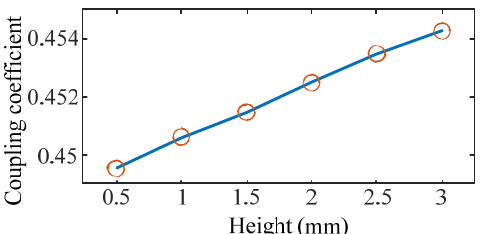
Figure 15. Coupling coefficient waveform with different heights.